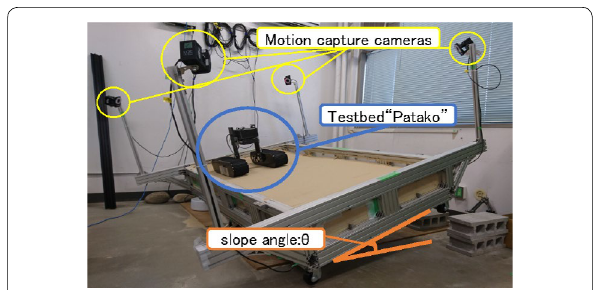
Fig. 5 Experimental setup